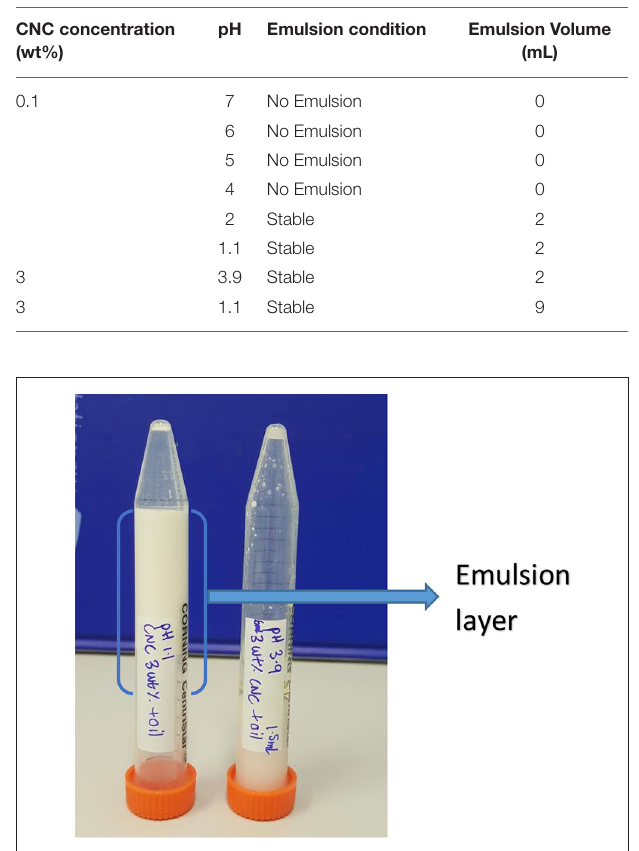
TABLE 1 | Effect of pH on the stability of C. Oil/water emulsions.